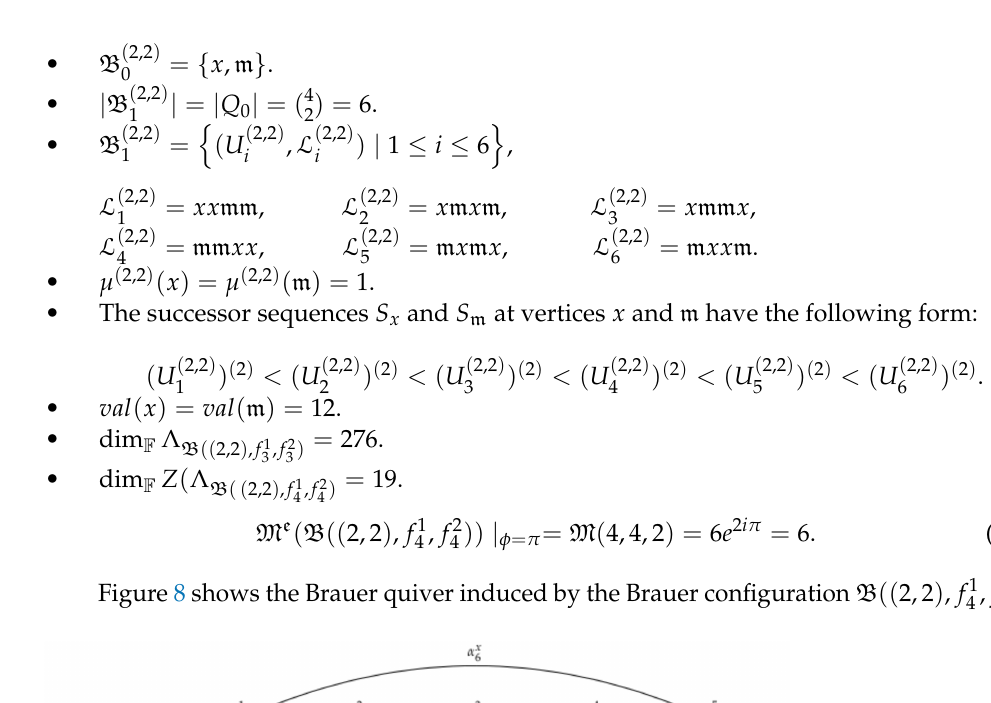
Figure 8. Brauer quiver associated with the labeled Brauer configuration B (( 2,2 ) , f 1 The specialized messages M e ( α , γ , β ) associated with Brauer configurations